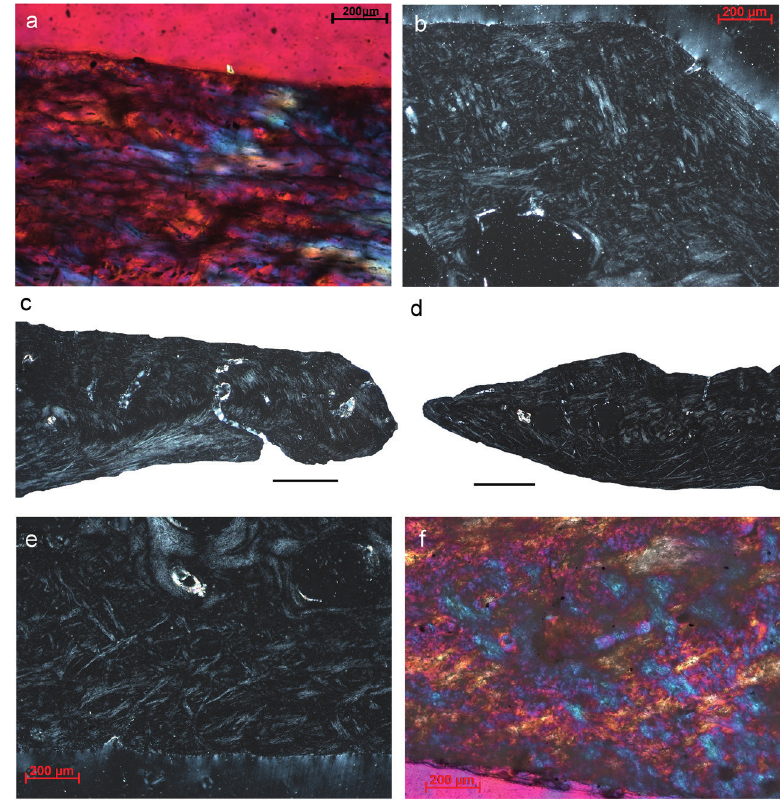
Figure 3 - histological details of the osteoderms of Riostegotherium yanei , a) aligned osteocyte lacunae at the superficial cortex (UFRJ-DG 1050M); b) the almost orthogonal pattern of collagen fiber bundles at the posterior part of the superficial cortex of the base (UFrJ-DG 1052M); c) layers of different directions near the posterior edge of the tongue give the false impression that the fibers are curved (UFRJ-DG 1053M); d) the thick fibers of the deep cortex are crossed by few fiber bundles oriented anterior and superficially (UFRJ-DG 1053M); e) detail of the irregular meshwork pattern of the deep layer, at the middle region of the osteoderm with polarized light; and f) λ compensator (UFrJ-DG 1052M and UFrJ-DG 1050M, respectively). Scale bar = 200 μm in (a) , 1 mm in (c) and 0.5 mm in (d)